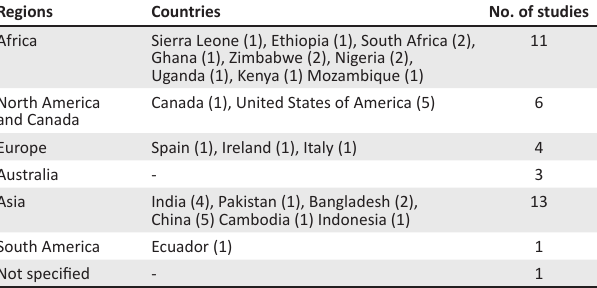
TABLE 1: Location of the studies. † Regions Countries No. of